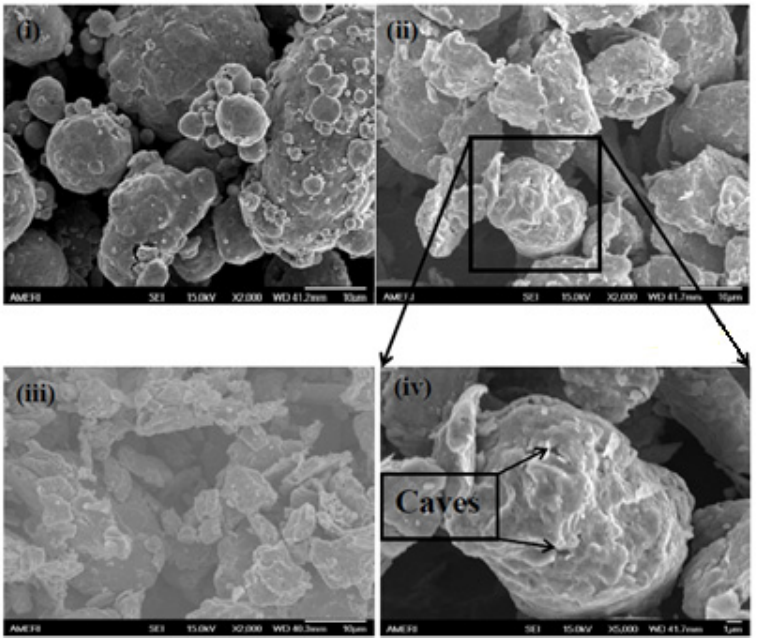
Figure 3. SEM image of Raney nickel ( i ) without; ( ii ) 2 h; ( iii ) 4 h ball milling at 2000× each and ( iv ) 2hball milled Raney nickel with pores (at 5000×).